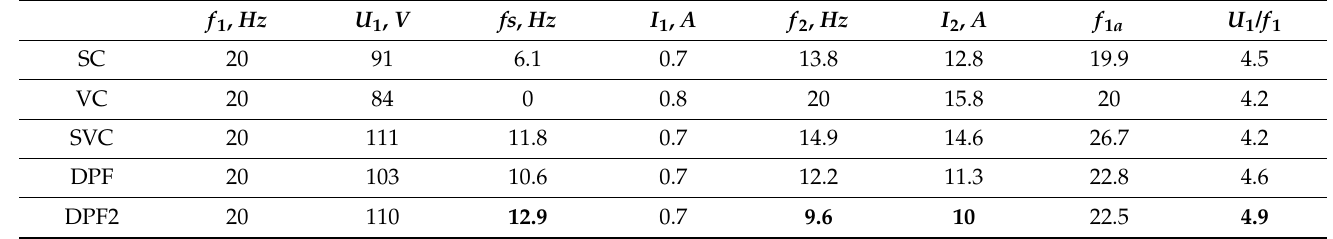
Table 2. At a load of 70% of Mm (the load is equivalent to the load drive setting of 15